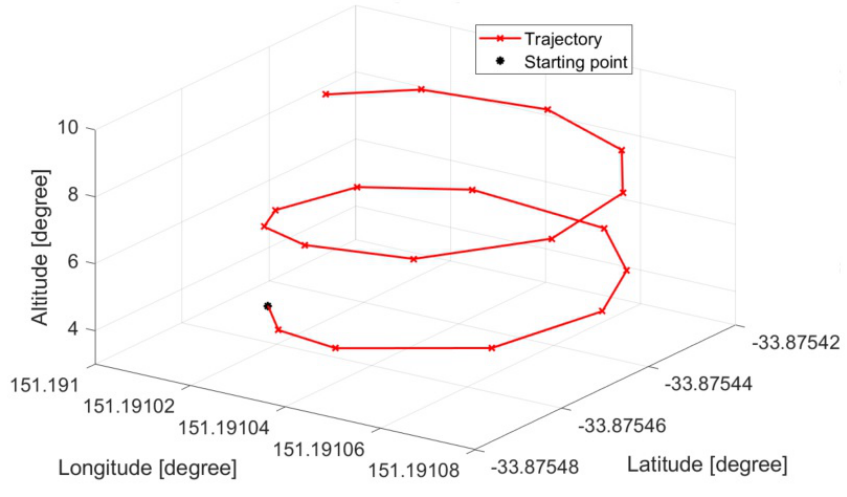
Figure 9. Predefined trajectory.